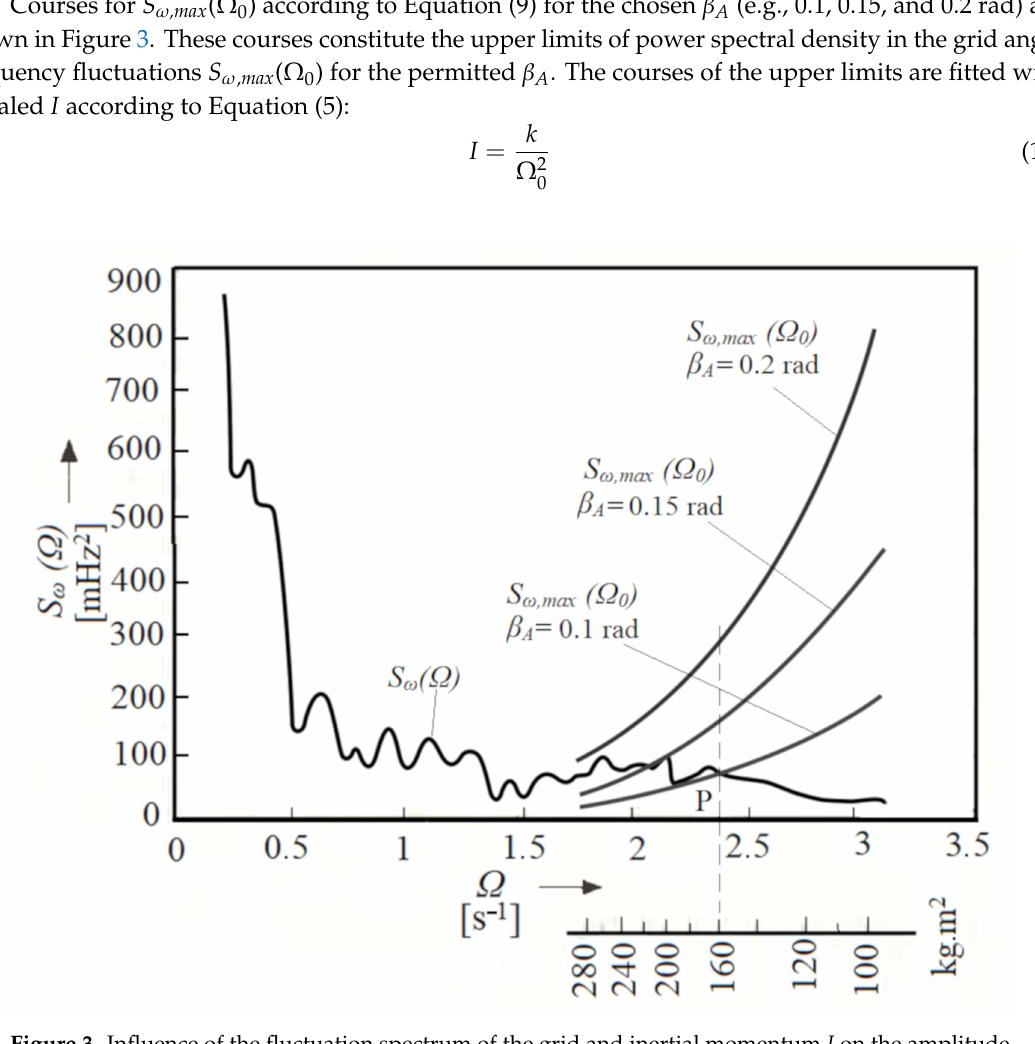
Figure 3. Influence of the fluctuation spectrum of the grid and inertial momentum I on the amplitude of angular